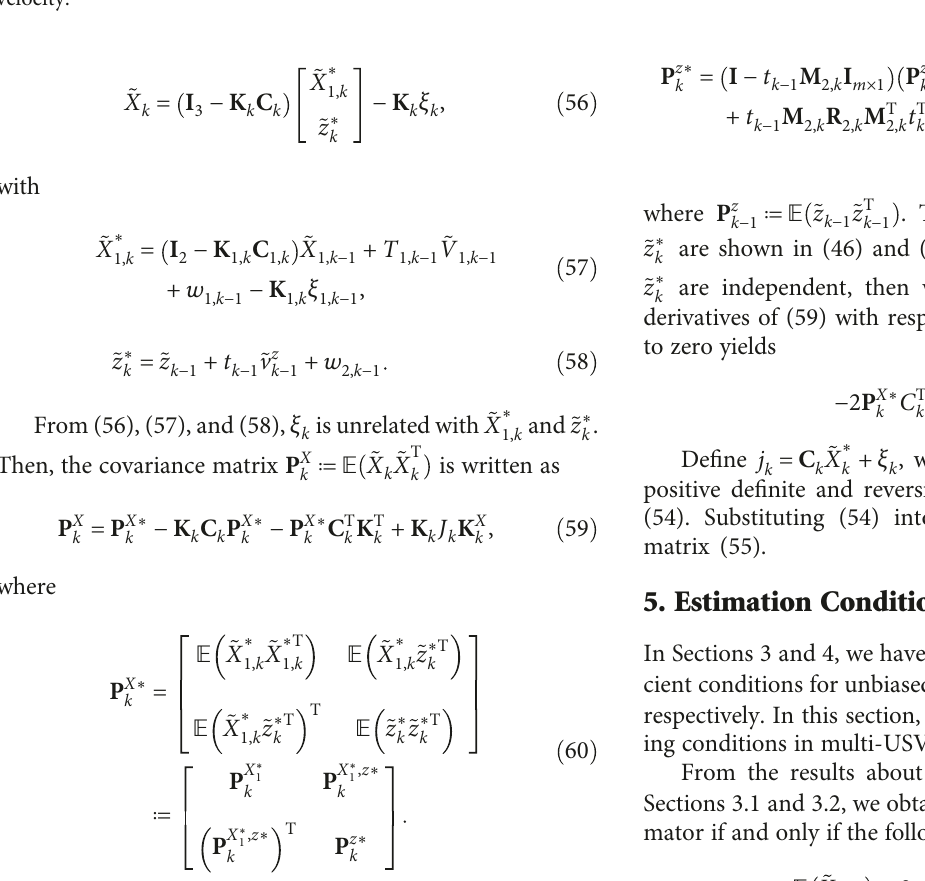
Figure 4: Comparison of the true and estimated values in optimal formation. (a) True and estimated position. (b) True and estimated